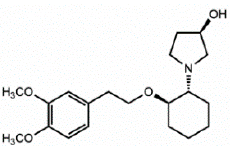
Figure 5. Stucture of Vernakalant.